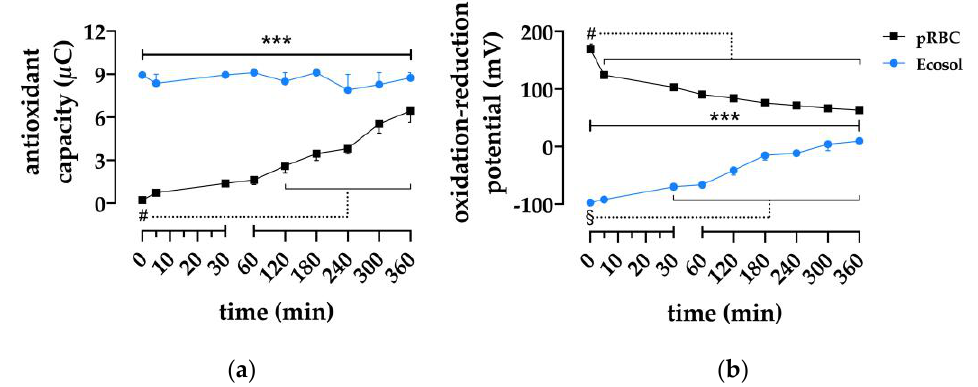
Figure 5. Effect of perfusate composition on antioxidative features. ( a ) Statistical analysis of antioxidant capacity and ( b ) oxidation-reduction potential; *** p < 0.001 (RBC vs. Ecosol); # p < 0.05 (RBC time point vs. RBC baseline); § p < 0.05 (Ecosol time point vs. Ecosol baseline).